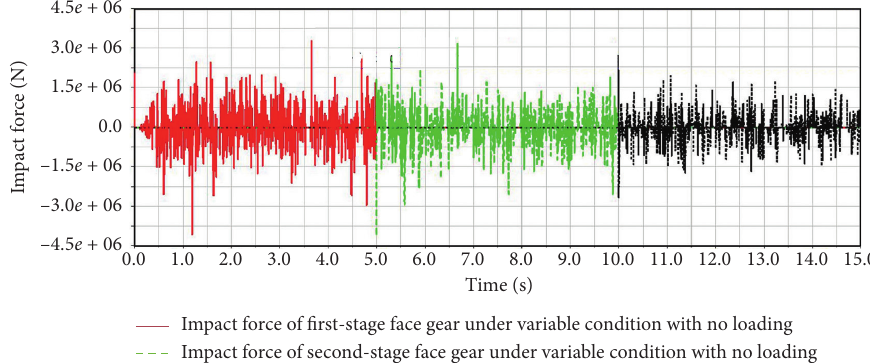
Figure 19: Impact force of multistage face gears pair under variable speed with no